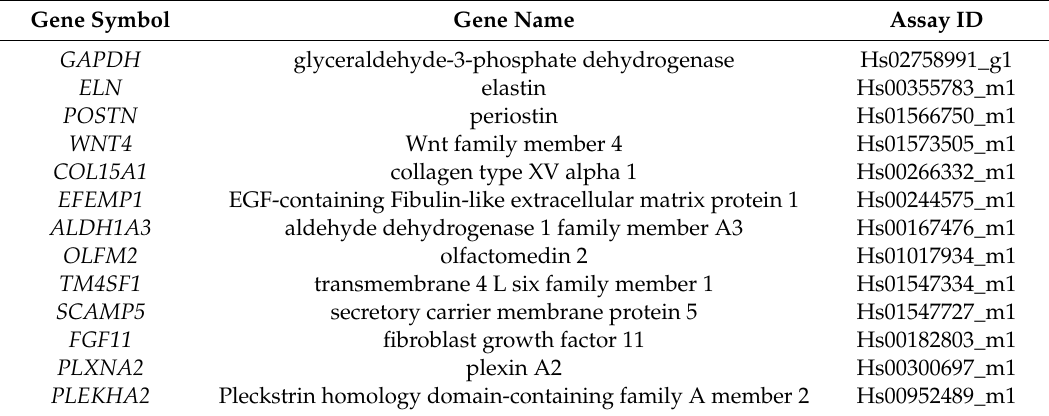
Table 2. Taqman gene expression assays used for quantitative